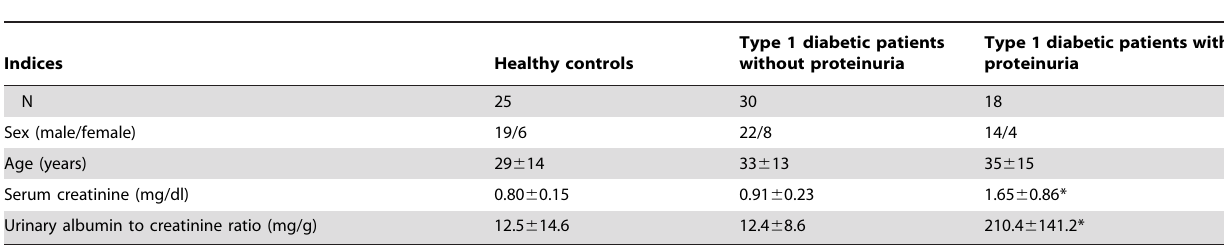
Table 1. Clinical characteristics of the subjects enrolled in the study.